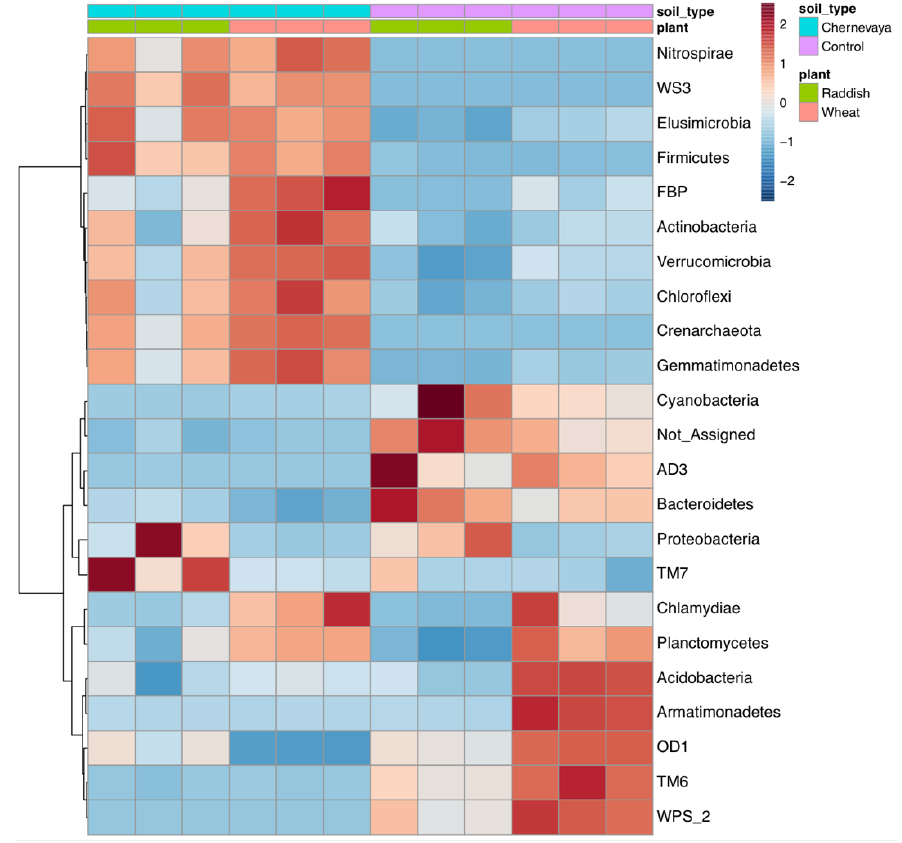
Figure 6. Heatmap diagrams showing the hierarchical clustering of the rhizosphere communities on the phylum level. Euclidean distance, Ward’s linkage clustering method.